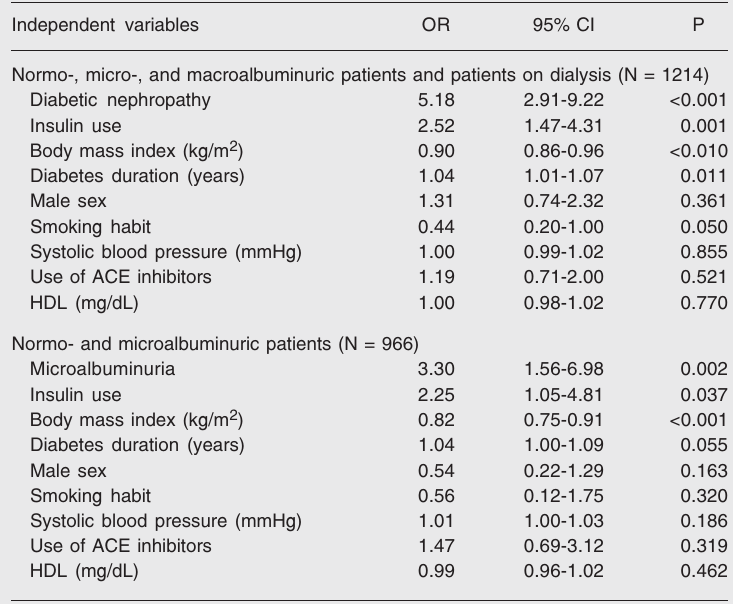
Table 2. Multiple logistic regression analysis. Independent variables